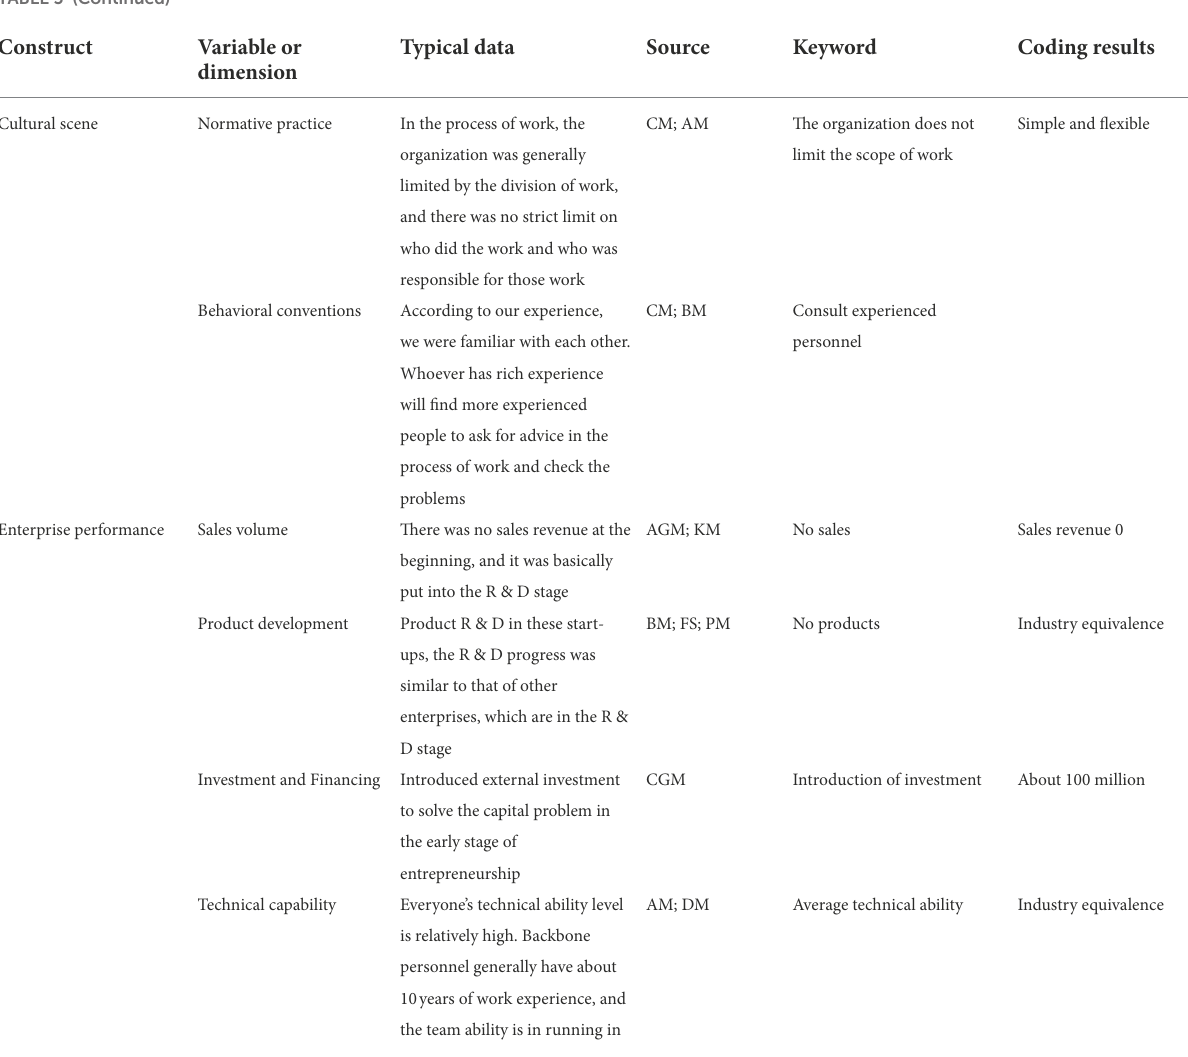
Table 6 for typical data and coding